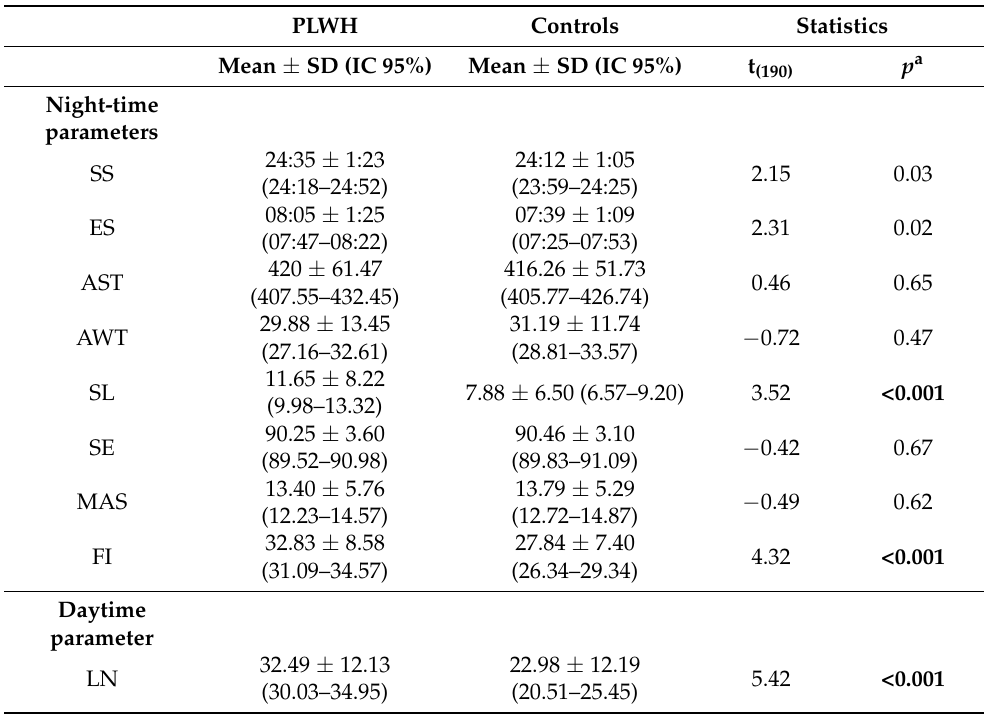
Table 1. Actigraphic night-time and daytime parameters in persons living with HIV (PLWH) and controls.